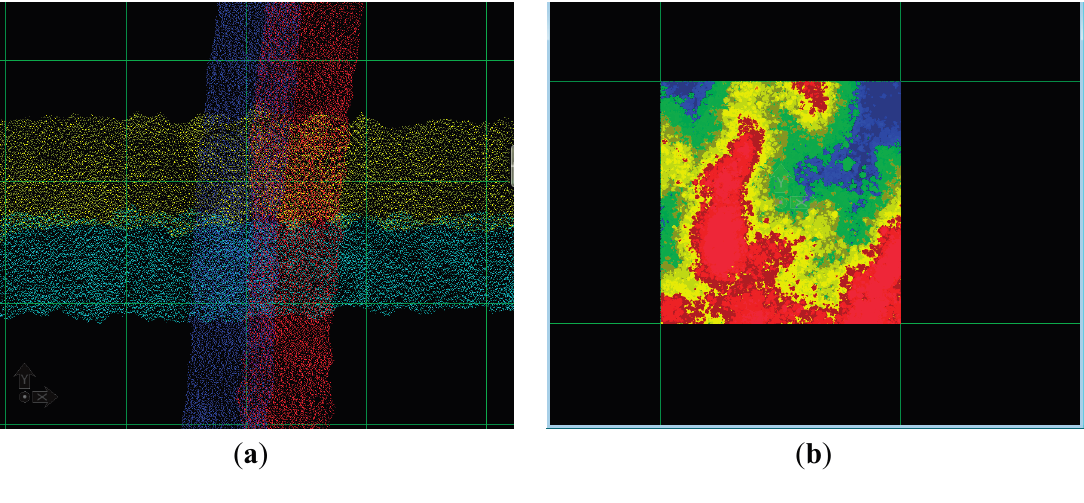
Figure 17. ( a ) Point cloud from different flight strips, each strip has a different color; ( b ) Point cloud from a project file combining all the data for an area from different strips into a single tile, the PC is colored by